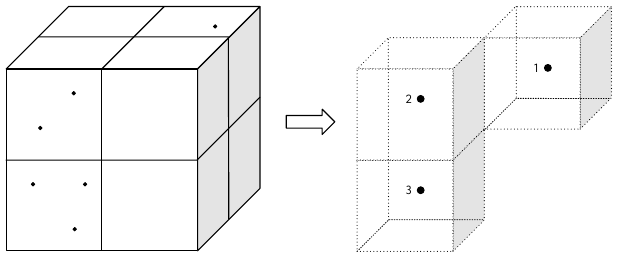
Figure 7. ( Left ) The points of the original point cloud inserted into an octree structure. The figure shows only a subset of the octree consisting of eight leaf nodes, where three of the voxels are occupied. ( Right ) After decompression, the reconstructed point cloud contains points at the center coordinate of the occupied voxels, in addition to the intensity value. In this example, the intensity value is generated by point counting. The dashed voxel cubes on the right-hand side are only shown for